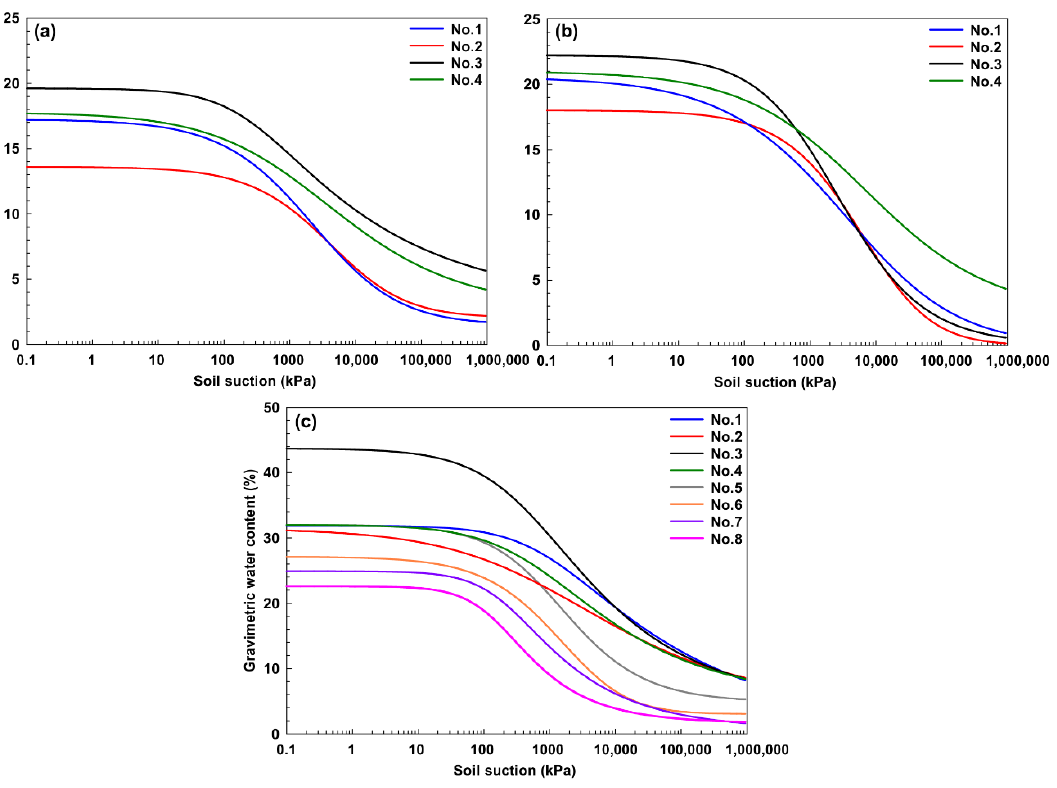
Figure 8. SWCCs of different soils with different sample preparation methods: ( a ) compacted at OWC, ( b ) compacted at the wet side of OWC, ( c ) consolidated from slurry. Table 4. SWCC properties of soils ( w ae = air entry water content, AEV = air entry value, w r = residual water content, α and n = VG fitting parameters).